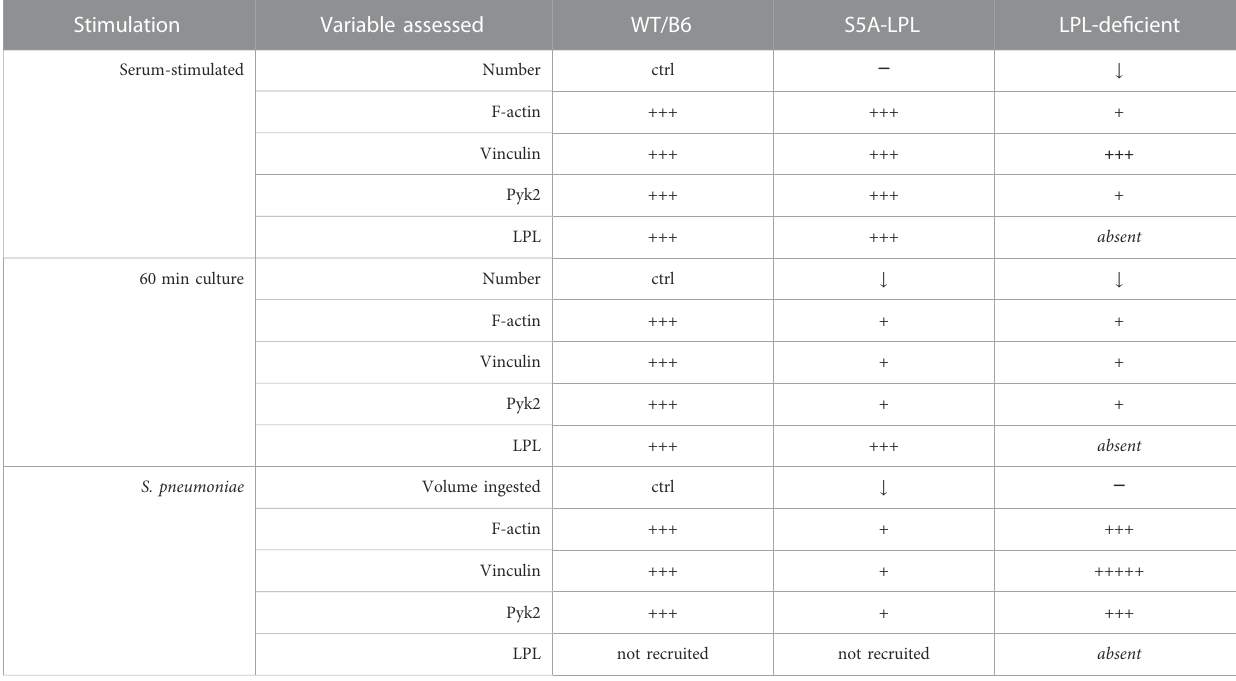
TABLE 1 Expression of S5A-LPL exerts different effects on nascent podosome initiation compared to LPL de fi ciency.